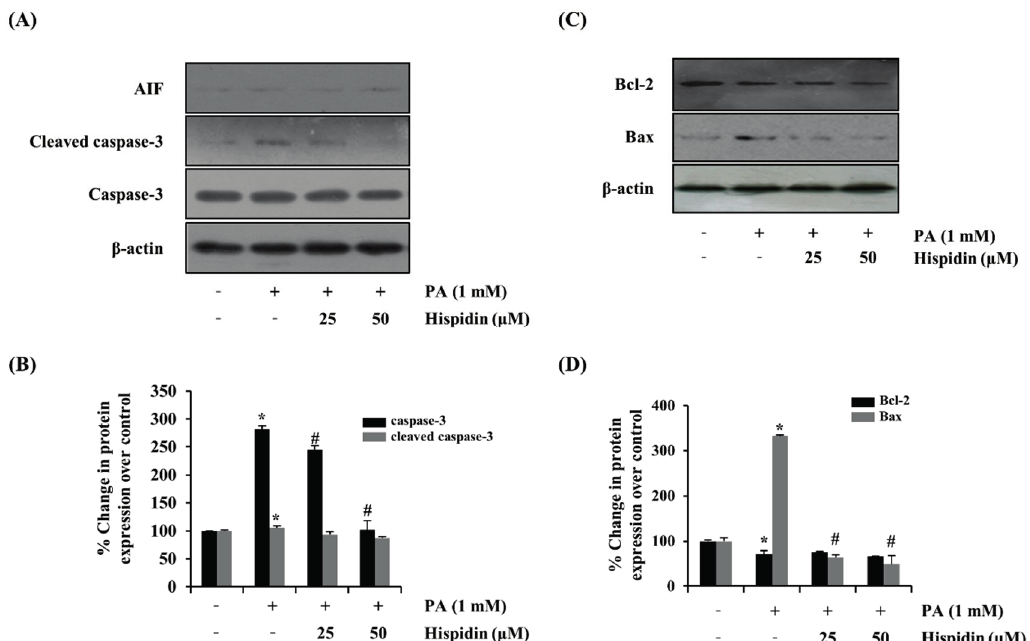
Figure 4. Effect of hispidin on the expression of apoptosis-associated proteins in palmitate-treated C2C12 myotubes. C2C12 myotubes were cultured with indicated concentration of hispidin for 8 h, and then exposed to 1 mM palmitate for 16 h. ( A ) The expression levels of AIF, cleaved caspase-3 and caspase-3 were assessed using western blot analysis. ( B ) Quantitative analysis of the band density of cleaved caspase-3 and caspase-3. ( C ) The expression levels of Bax and Bcl-2 were assessed using western blot analysis. ( D ) Quantitative analysis of the band density of Bax and Bcl-2. The equal loading of the total proteins in each sample was confirmed by the expression of β -actin. Data represent the mean ± standard error of three independent experiments. * p < 0.05, as compared with only BSA group, # p < 0.05, as compared with PA group. AIF, apoptosis-inducing factor; Bcl-2, B-cell lymphoma 2; Bax, Bcl-2-associated X